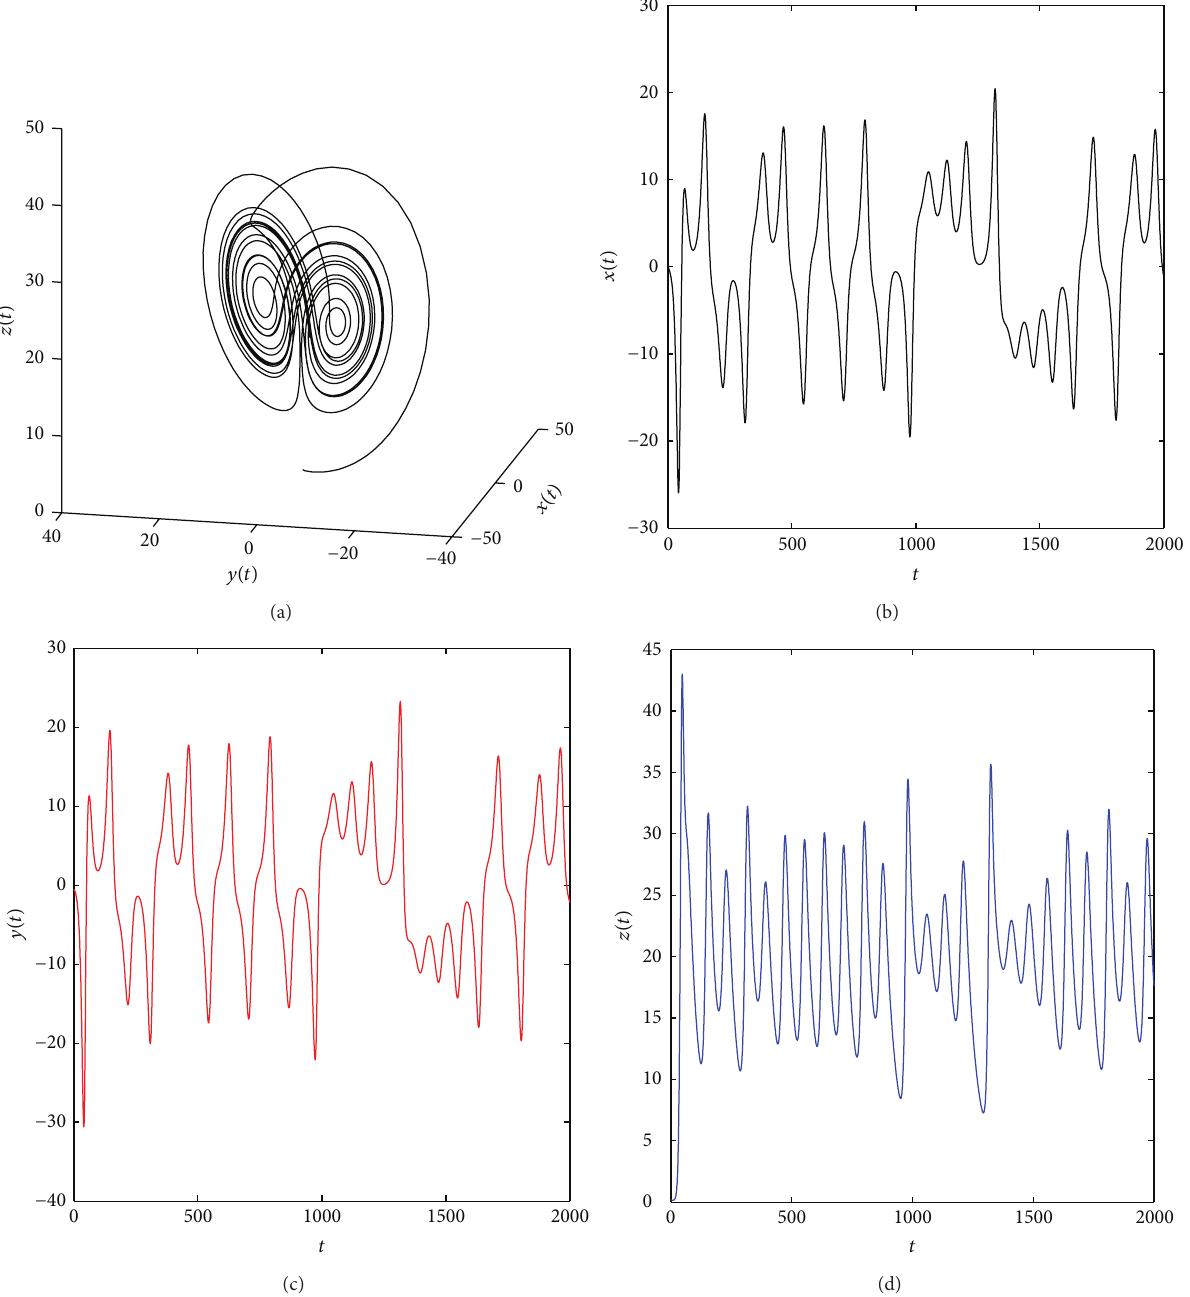
Figure 6: Chaotic attractor of the distributed order fractional Chen system (22) with ( 𝑞 11 ,𝑞 12 ,𝑞 21 ,𝑞 22 ,𝑞 31 ,𝑞 32 ) = (0.95, 0.1, 0.95, 0.1, 0.95, 0.1) and (𝑎,𝑏, 𝑐) = (35, 3, 28)